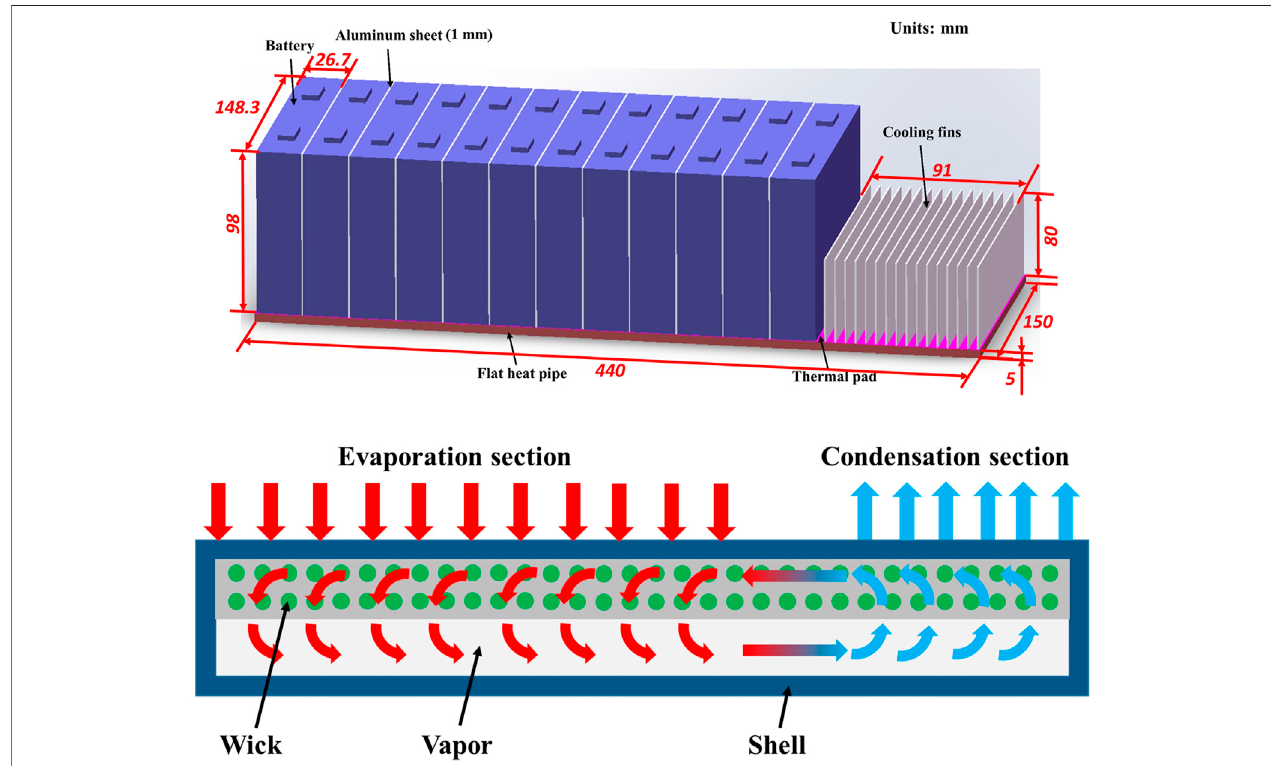
FIGURE 1 | (A) Schematic of BTMS based on fl at heat pipe. (B) Inside structure and schematic representation of an FHP.